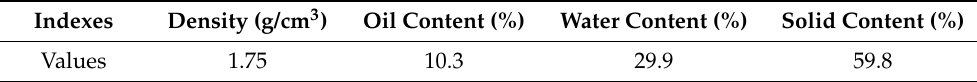
Table 1. Composition of oily